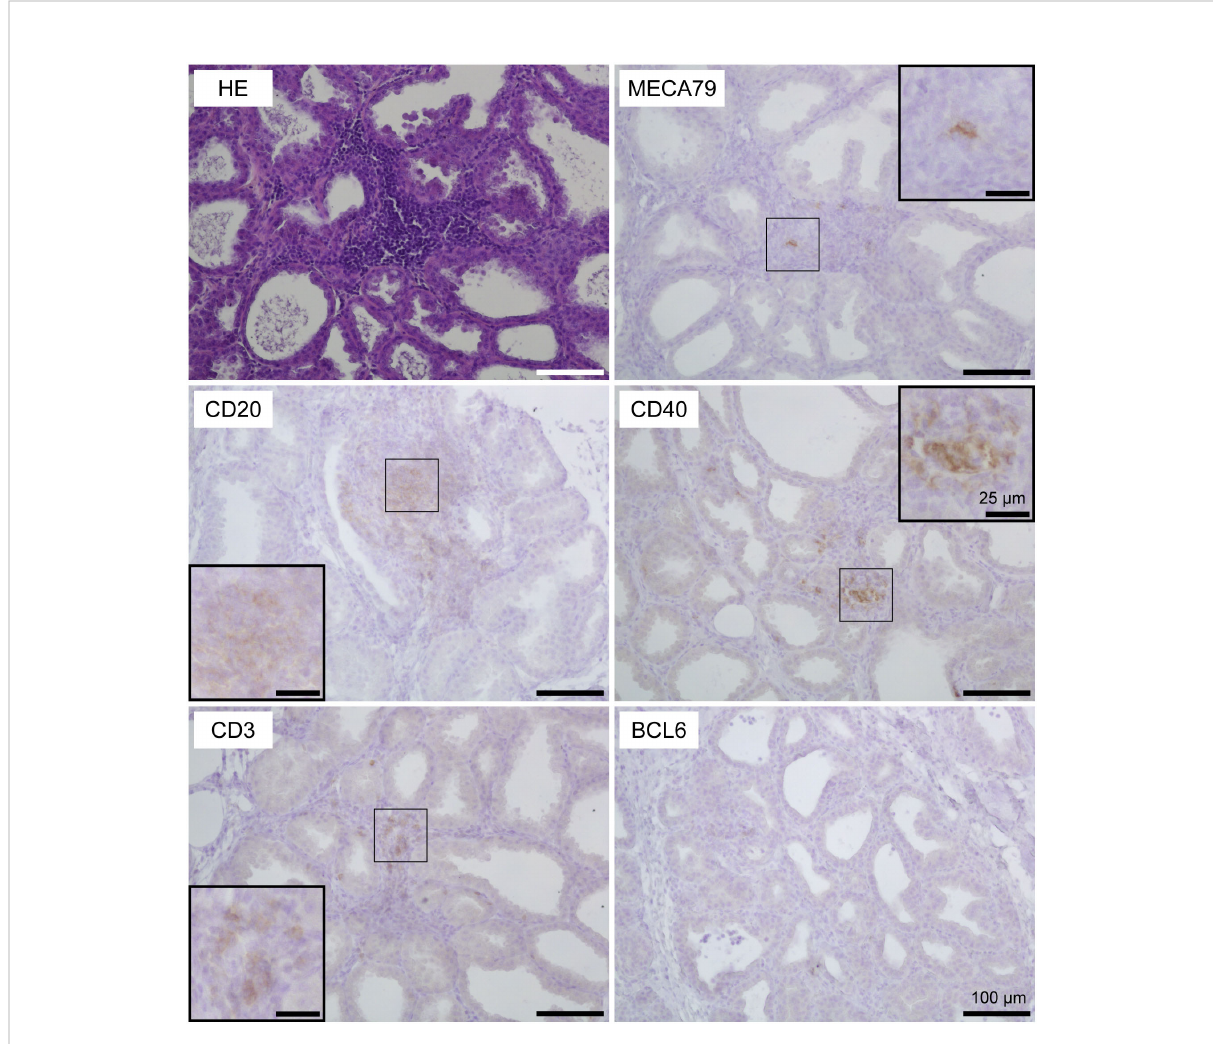
FIGURE 1 Representative images of hematoxylin and eosin staining (HE) and immunohistochemistry against CD20 (B cells), CD3 (T cells), MECA79 (high endothelial venules; HEVs), CD40 (follicular dendritic cells), and BCL6 (germinal center) in a small-sized aggregation of lymphocytes in goat mammary gland tissues. Scale bar, 100 m m or 25 m m